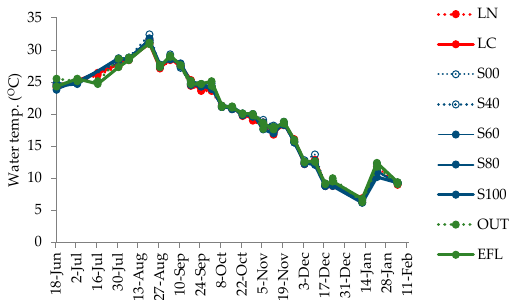
Figure 6. Changes in water temperature.